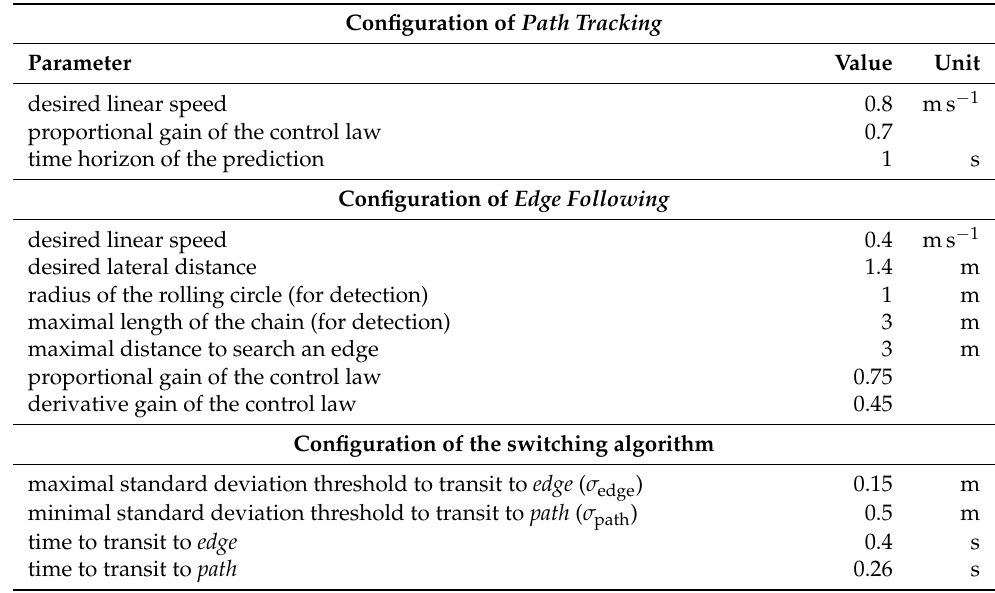
Figure 7. Presentation of the experiment with edge following . ( a ) Scenario; ( b ) picture at the end of the hedge. Table 1. Configuration of the experimentation with edge following